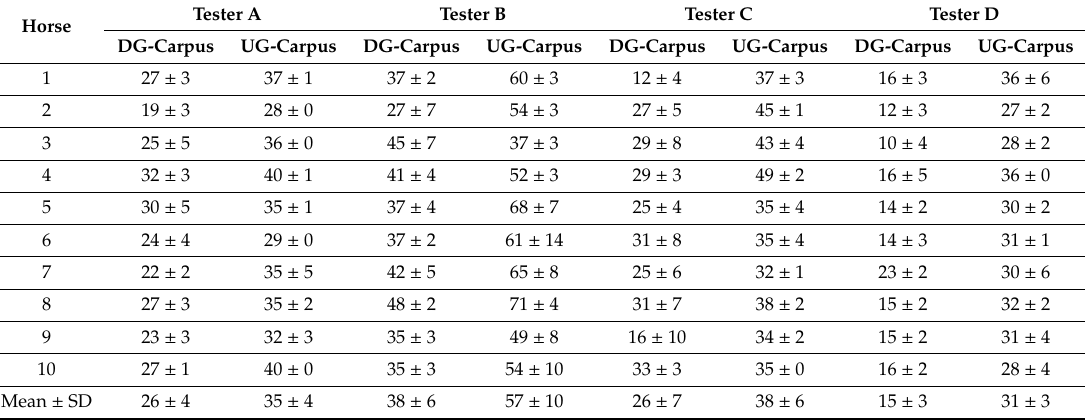
Table 2. Joint angles of carpal joint flexion, as performed on ten horses by four testers and with two types of goniometers. Values are presented as mean ± standard deviation, and in degrees. Tester A Tester B Tester C Tester Horse